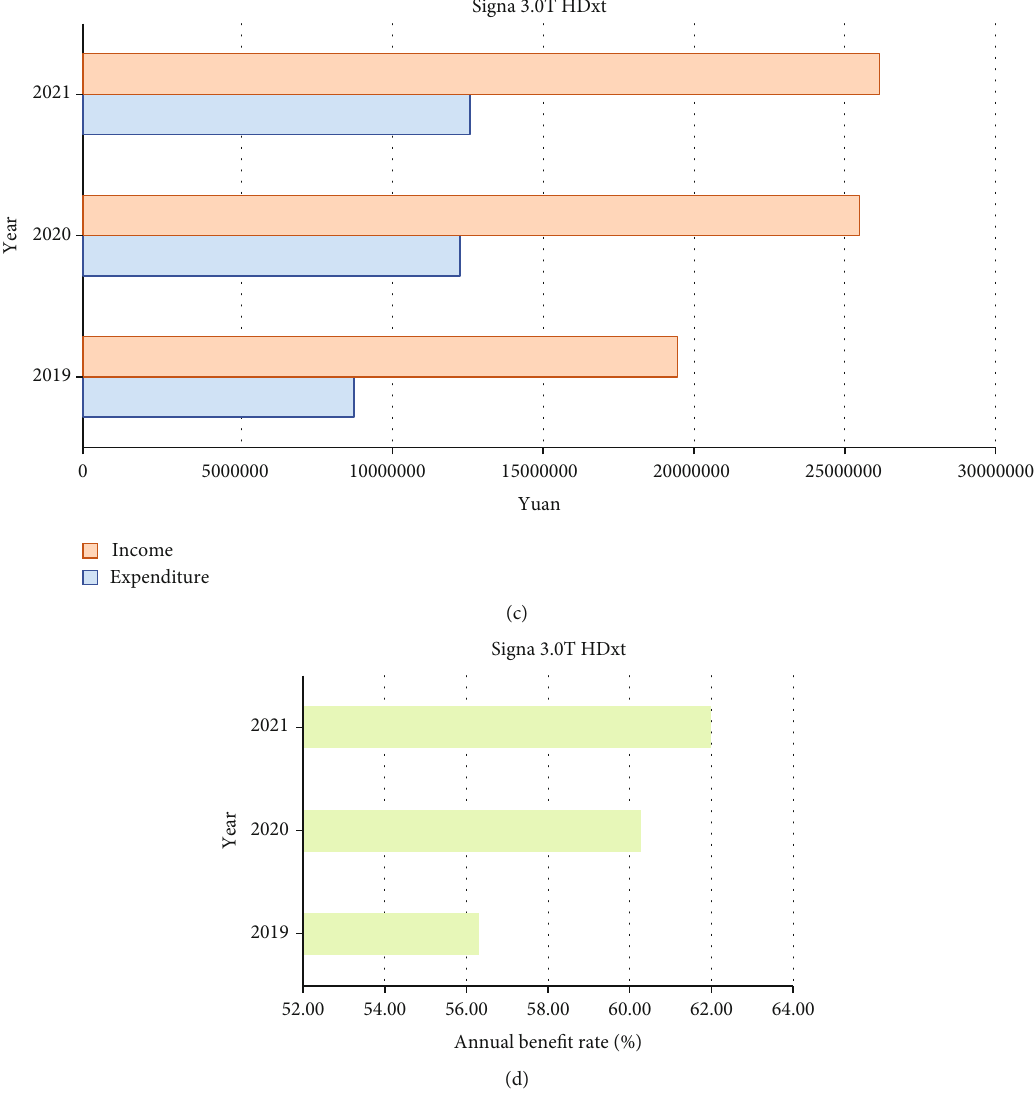
Figure 4: Analysis of operation costs of Discovery MR 750 W and Signa 3.0 T HDxt (3.0 T MR). (a, c) The annual revenue and expenditure of the Discovery MR 750 W and Signa 3.0T HDxt from 2019 to 2021. (b, d) The annual bene fi t rate of Discovery MR 750W and Signa 3.0T HDxt from 2019 to